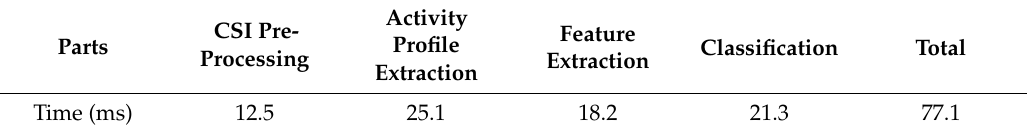
Figure 14. Comparison of execution time. Table 5. Execution time of processing parts per activity.